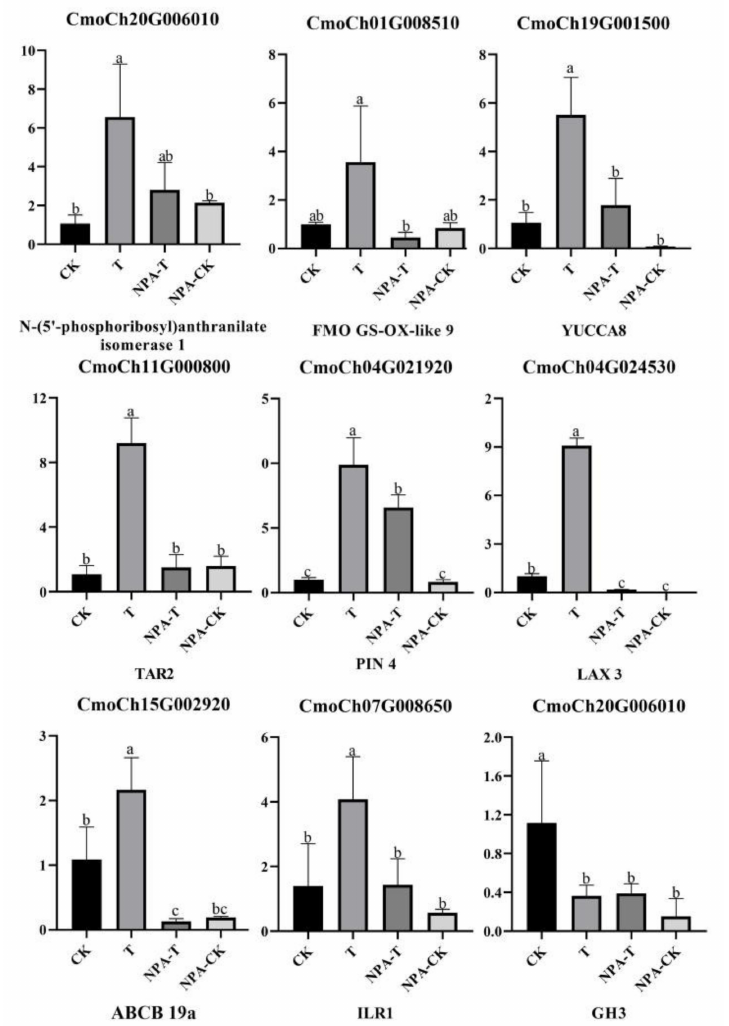
Figure 5. Expression of eight genes associated with hypocotyl elongation during EOD-FR treatment. Different lowercase letters indicate a significant difference at the 5% level between